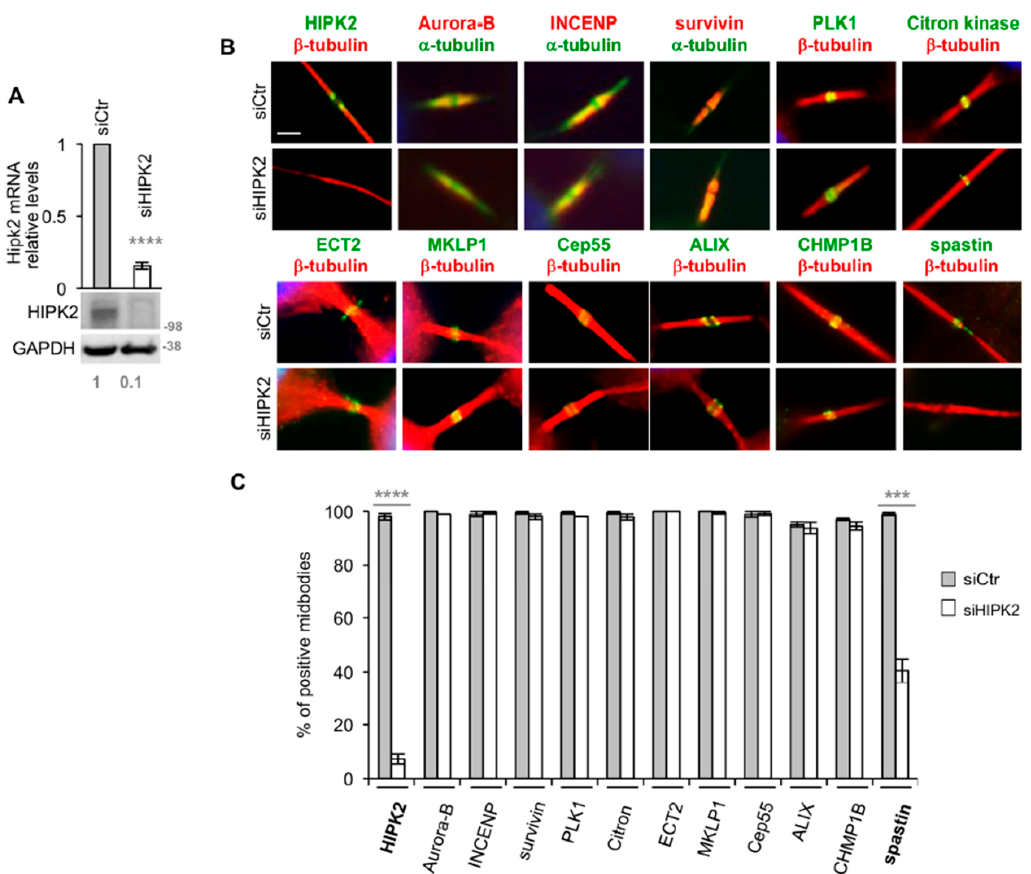
Figure 1. Spastin localization at midbody is reduced in HIPK2-depleted cells. ( A , C ) HeLa cells transfected with a mix of three validated HIPK2-specific (siHIPK2) or negative control (siCtr) stealth siRNAs were analyzed by real-time (RT)-PCR, WB and IF 96h post transfection. Molecular weight markers are reported here and in the following figures in kilodalton (kDa). Values are mean ± standard error of mean (SEM) from two independent experiments, each performed in triplicate. **** p < 0.0001, t-test. Representative WB is shown and relative densitometric values of HIPK2/GAPDH are reported below each lane. IF was performed with Abs, recognizing indicated proteins in combination with anti- α - or - β -tubulin, to mark midbody and DAPI to stain DNA. In ( B ), representative immunostainings of midbody magnification are shown. Bar, 2 µM. In ( C ), data quantification is shown, values are mean ± SEM from three independent experiments, each performed in duplicate, and >100 midbodies were analyzed per condition. Note that, to avoid alterations of the IF signals , siHIPK2 midbodies showing >2 tubulin-labelled puncta were excluded by this analysis ; *** p < 0.001 ( p = 0.0002), t-test.